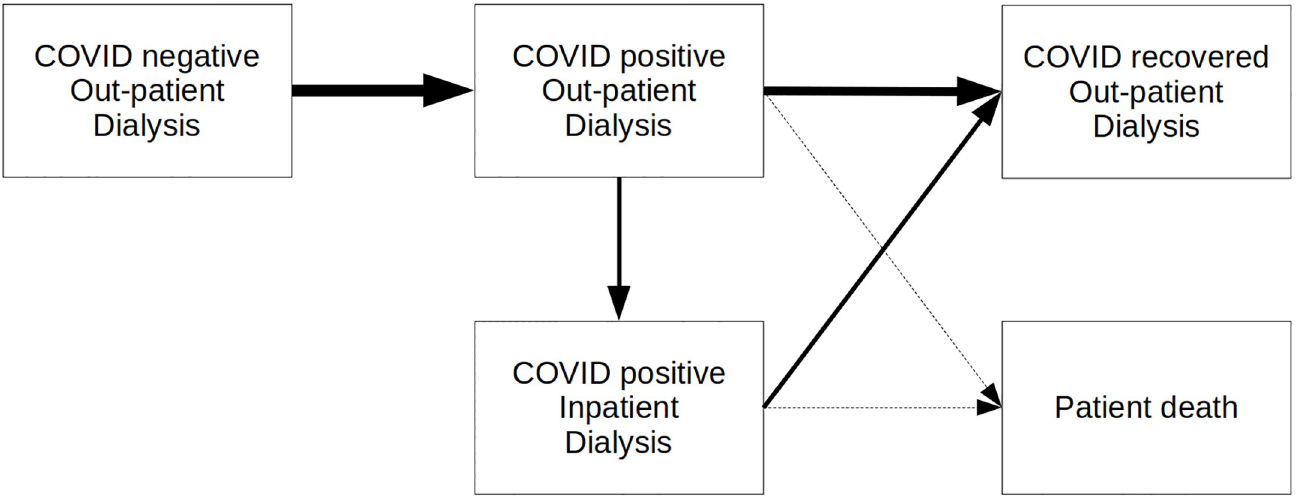
Fig 1. Schematic representation of patient pathway.